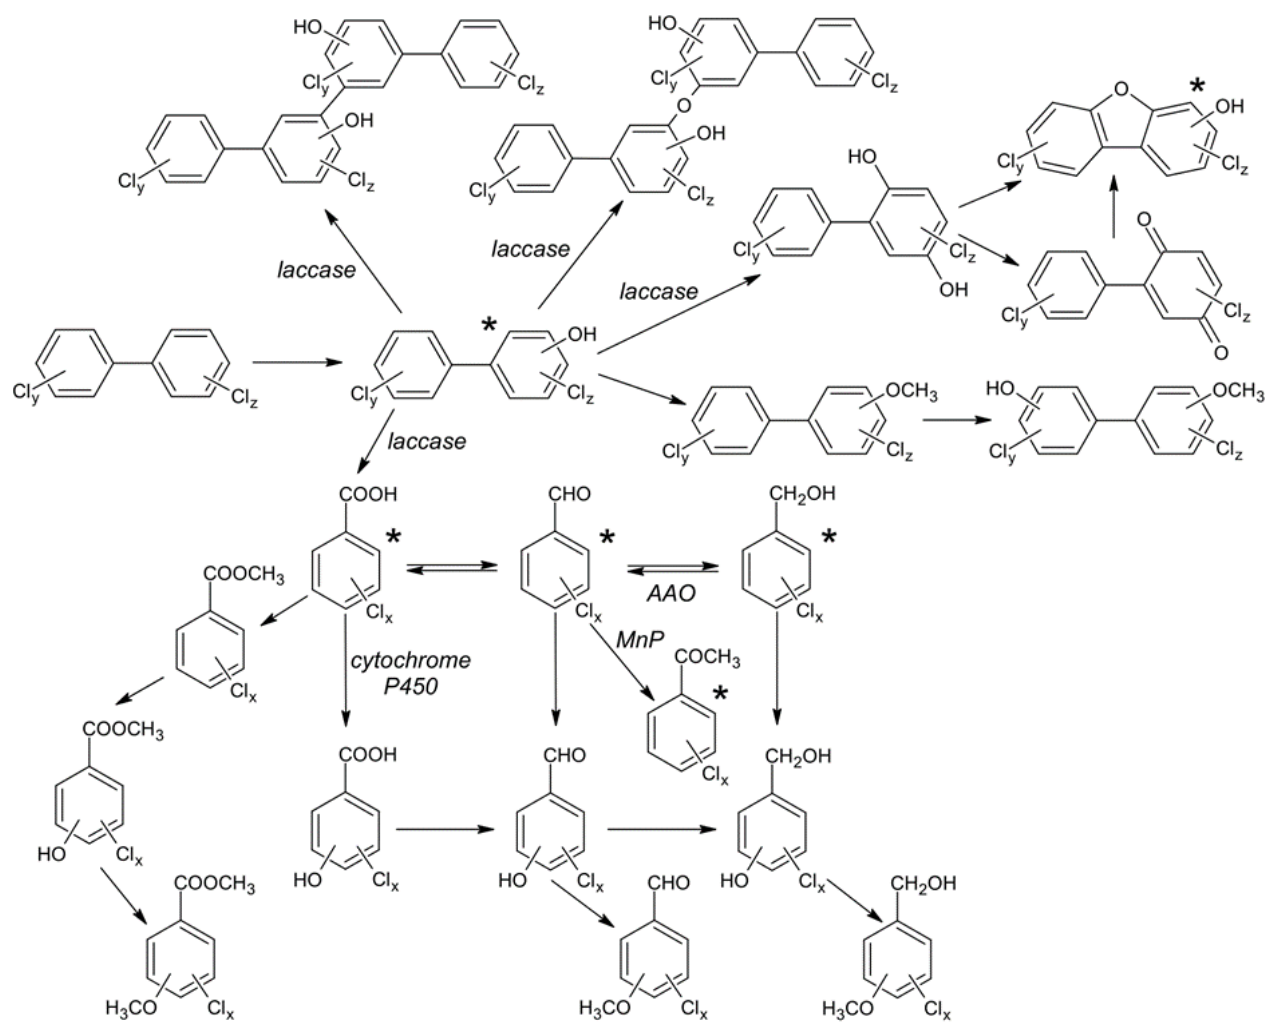
Figure 4. Pathways of the biotransformation of PCBs and their metabolites by ligninolytic fungi as proposed in the in vivo and in vitro studies by Čvančarová et al., Kamei et al., Muzikář et al., Schultz et al., Fujihiro et al., Kordon et al., Stella et al., and Ferreira et al. [1,2,4,18–21,31] and in this work. Where possible, enzyme involvement is stated. The asterisks denote compounds under study in the present work and the detected metabolites. MnP = manganese-dependent peroxidase; AAO = aryl-alcohol oxidase.